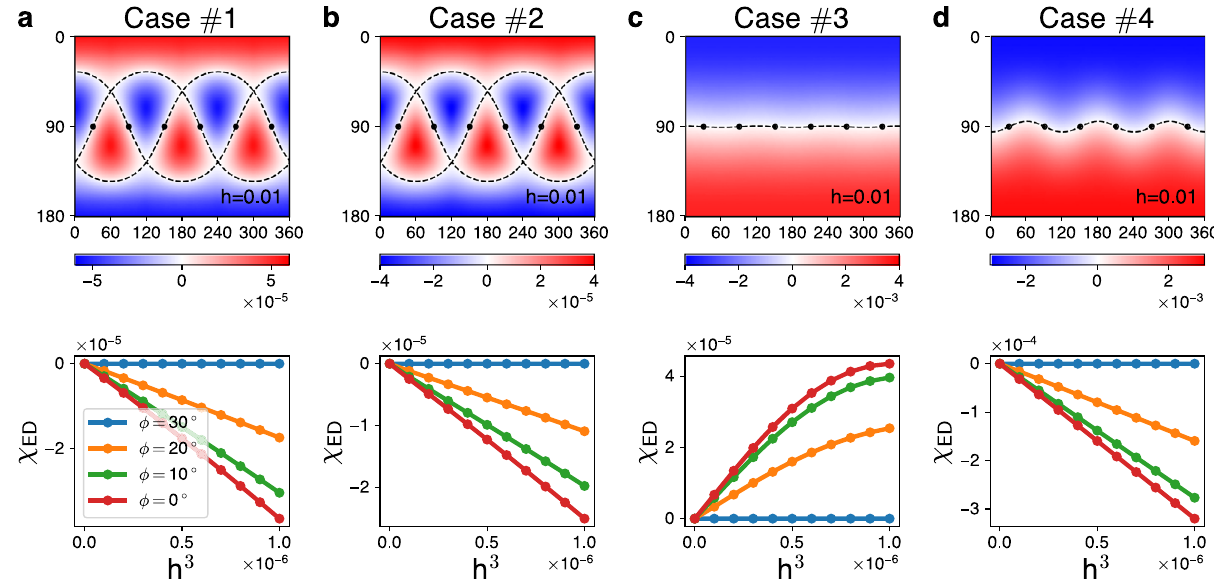
Fig. 2 Chirality of the non-abelian KQSL. Upper: color maps of the chirality χ ED ( h ) on the plane of the fi eld angles ( θ , ϕ ), where the magnetic fi eld strength is fi xed by h = 0.01 (horizontal axis: ϕ [°], vertical axis: θ [°]). The dashed lines highlight the zero lines χ ED ( h ) = 0, and the black dots mark the bond directions. Lower: χ ED ( h ) as a function of h 3 for the in-plane fi elds ( θ = 90 ∘ , ϕ = 0 ∘ , 10 ∘ , 20 ∘ , 30 ∘ ), illustrating the universality of the h 3 behavior in the KQSL. In the case # 3, the bending at h 3 > 0.5 × 10 − 6 is an effect of higher order contributions ( h 5 , h 7 , ...). The parameter sets used in the four cases ( # 1~4) are listed in Table 1.